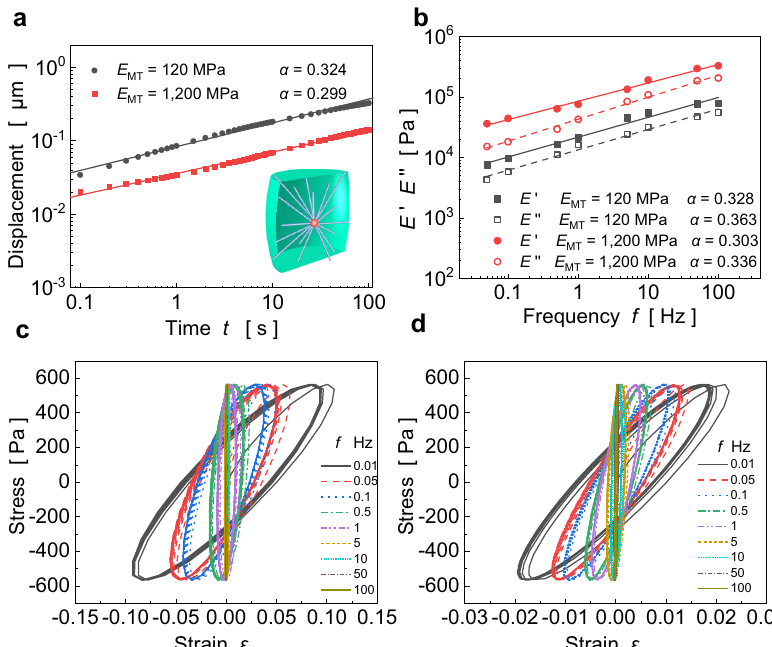
Fig. 1 Rheological responses of the adopted cell model under step and cyclic loads. a Displacement over time on the log – log scale for E MT ¼ 120MPa and E MT ¼ 1200MPa. b Storage modulus E 0 and loss modulus E 00 over the loading frequency f on the log – log scale for E MT ¼ 120MPa and E ¼ 1200MPa. Lissajous fi gures of stress – strain curves under different frequencies for c E MT